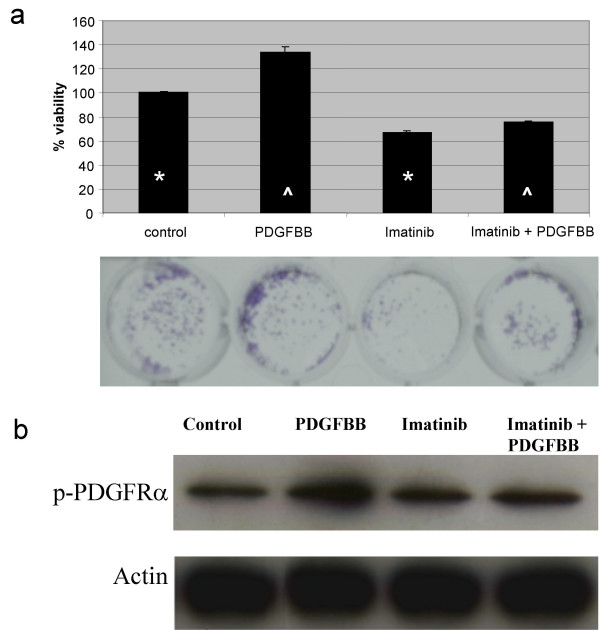
a) Effect of imatinib in cervical cell line growth. CaLo cells were grown for two days in the absence of serum and then re-plated for treatment with imatinib, PDGFββ or both for five days. PDGFBB stimulated cell gowth as compared to the untreated control. On the contrary imatinib induced growth inhibition and when cells were co-treated with the ligand and imatinib, the growth-inducing activity of the PDGFBB was partly blocked by imatinib (comparison are marked with * or ^, all these differences were statistically significant p < 0.001). Their corresponding pictures of the plates stained with crystal violet is shown below. b) Inhibition of phosphorylation of PDGFRα by imatinib. CaLo cells were stimulated with PDGFBB at 10 ng/mL, for 10 min; treated with imatinib at 10 μM for 2 hours; treated with imatinib for two hours and then with PDGFBB for 15 min; or no treatment as control. Equal loading confirmed with actin. Receptor phosphorylation is increased in the PDGFBB lane and inhibited by imatinib treatment.